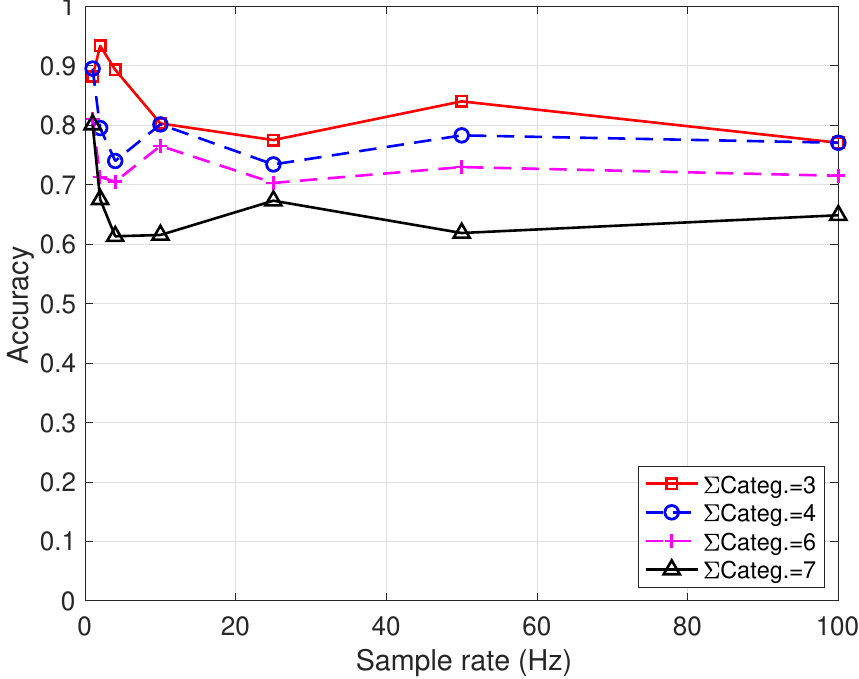
Figure 10. Classification accuracy versus sensor sample-rate. Sensor = acceleration, no. of hidden units = 150, solver =